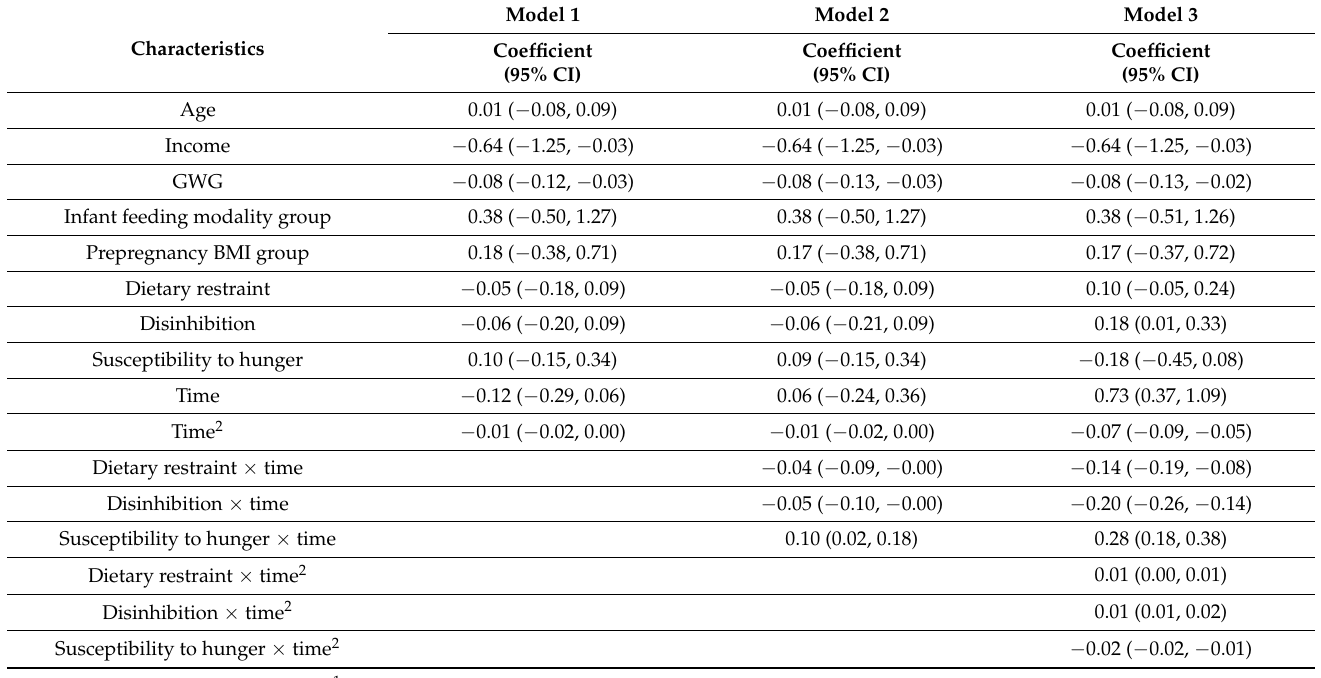
Table 3. Coefficients from mixed-linear effects models on the influence of psychological eating behaviors of women on the trajectory of BMI changes across first year postpartum 1 .